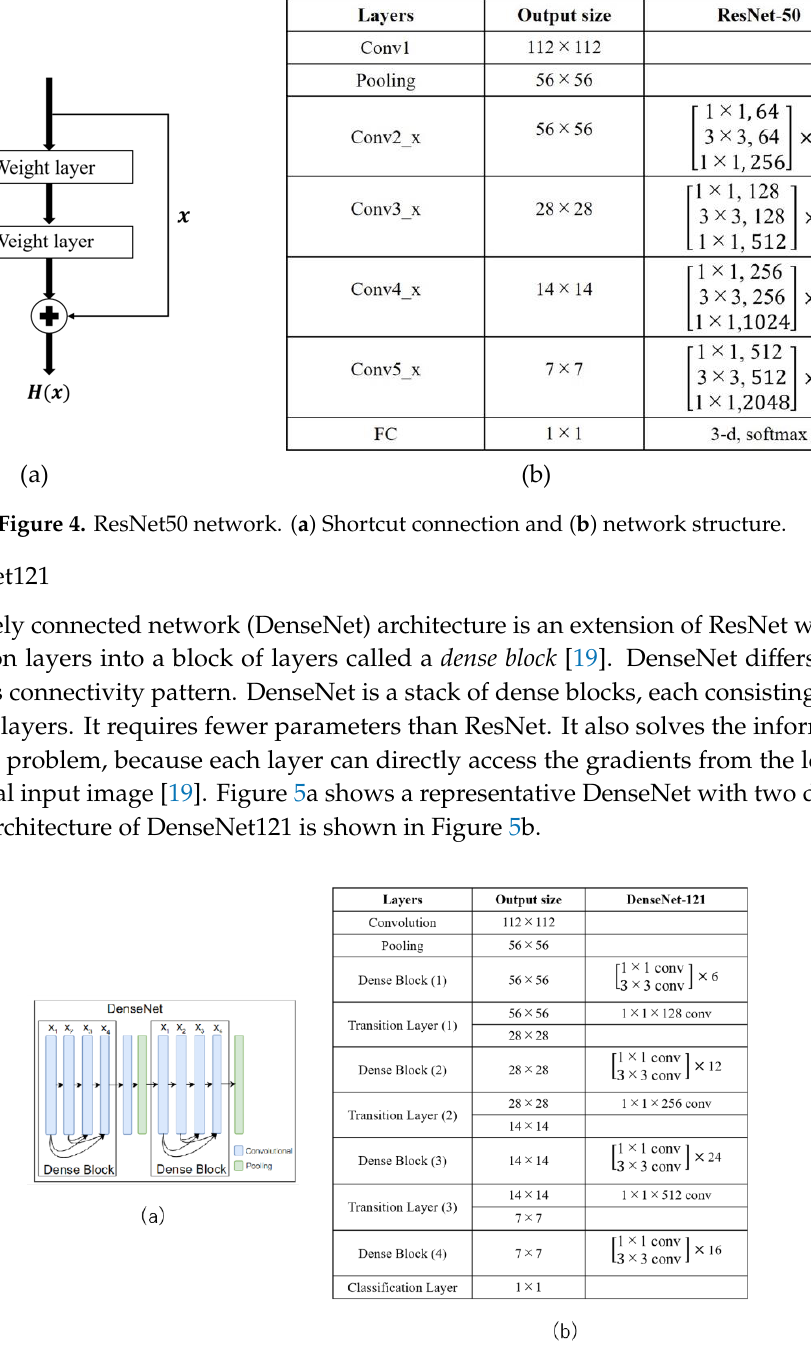
Figure 5. ( a ) Example of a DenseNet with two dense blocks and ( b ) DenseNet121 structure.